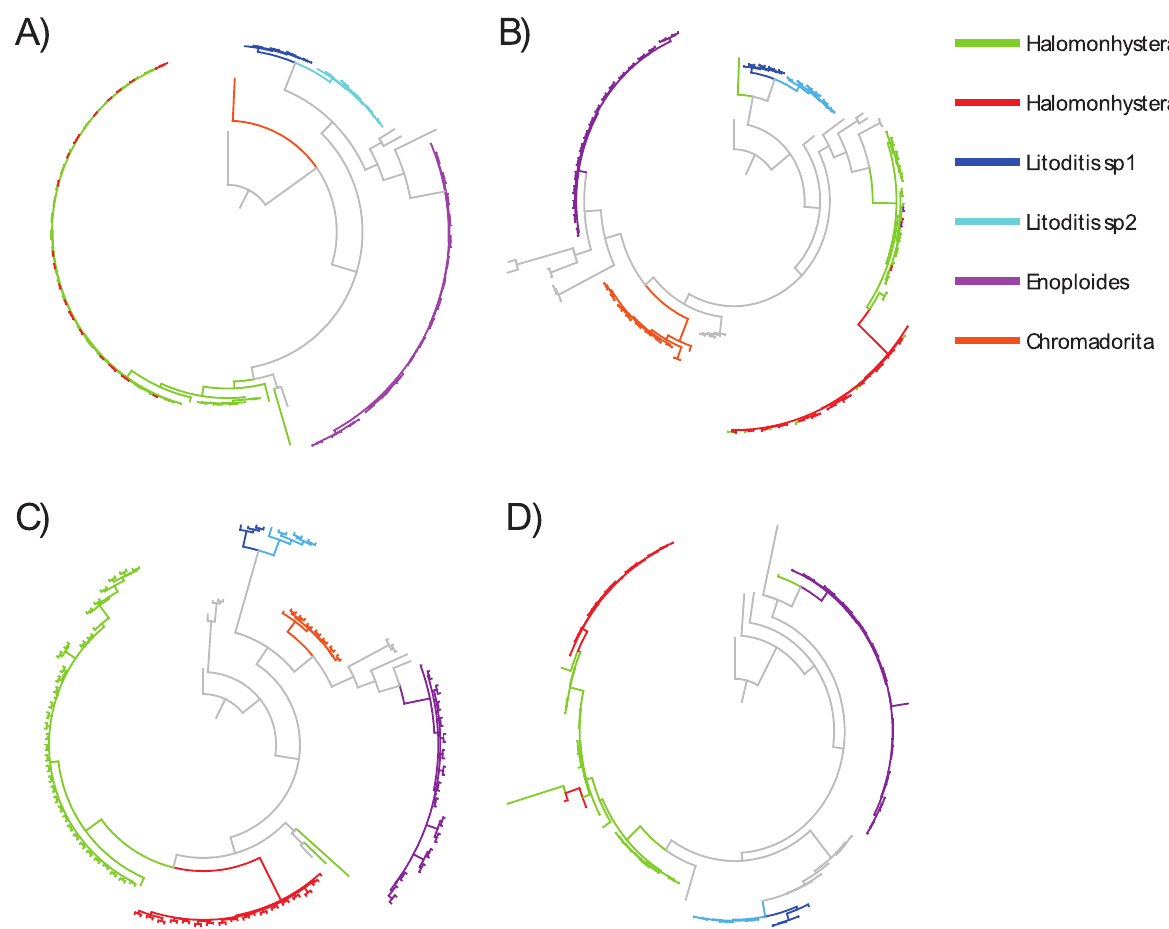
Fig 2. Bayesianphylogenetic tree constructed for A) LSU, B) SSU2, C) SSU1, and D) combine sequences. Coloursare related to the morphological identifications in S1 Table. supported by posterior probability included Enoploides (pp = 0.65), and Litoditis (pp = 0.99) (Fig 2C, S2 Fig). For SSU2 the phylogenetic tree main clades included Halomonhystera (pp = 0.95), Enoploides (pp = < 0.5), Litoditis (pp = 0.71), and Chromadoridae (pp = 0.99) (Fig 2B, S3 Fig). The concatenated tree showed the same main clades of Halomonhystera (pp = 0.92), Enoploides (pp = 1.0), and Litoditis (pp = 1.0) (Fig 2D). All phylogenetic trees built resolved two well-differentiated clades for the genera Halomonhystera and the Litoditis (Fig 2). In addition, in all phylogenetic trees other less representative clusters included Oncholaimidae, Cyatholaimidae, Tripyloididae, Selachinematidae, Xylidae (Fig 2). Both, the maximum likeli- hood and the Bayesian solution of the bPTP analyses suggested that there were between 32 and 39 species (Acceptance rate: 0.120988, Merge: 249699, and Split: 250301), resulting in a mean value of 35 putative species (Fig 3).